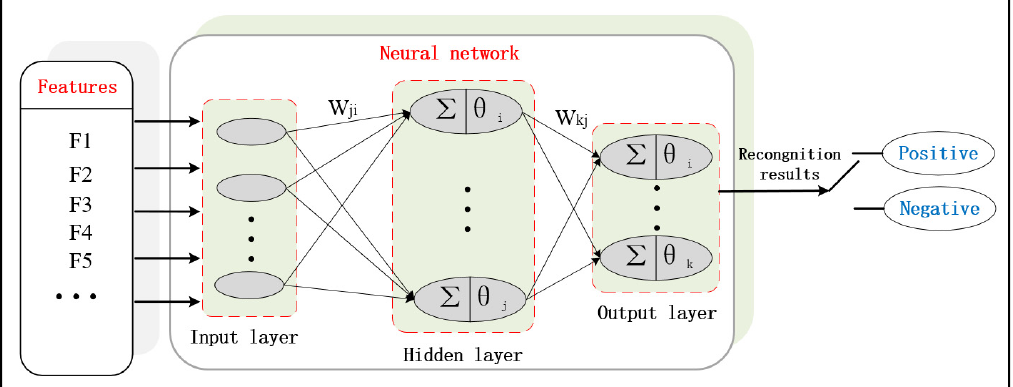
Figure 9. Structure of the established neural network.